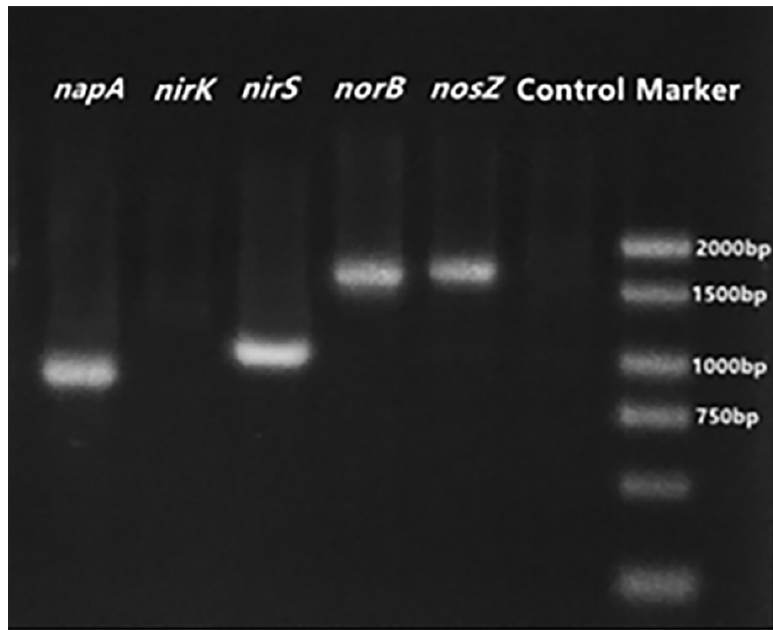
Figure 2. Amplification of functional genes involved in denitrification in strain 41.